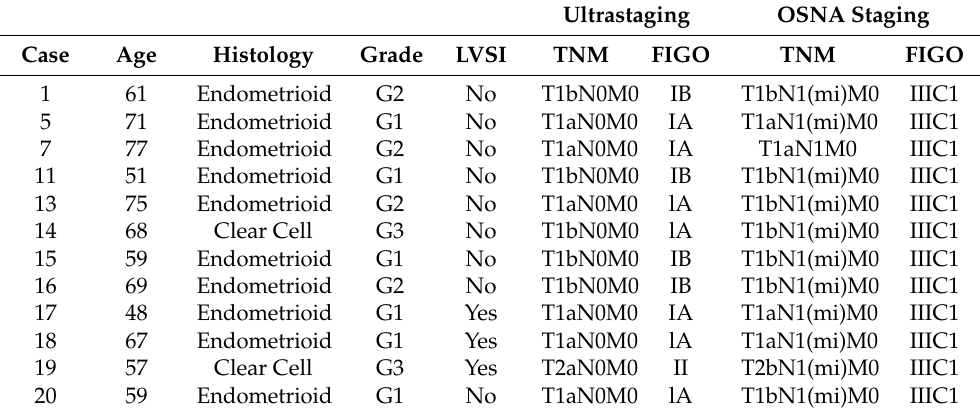
Table 5. Changes in the TNM and FIGO staging according to the results of the OSNA assay.